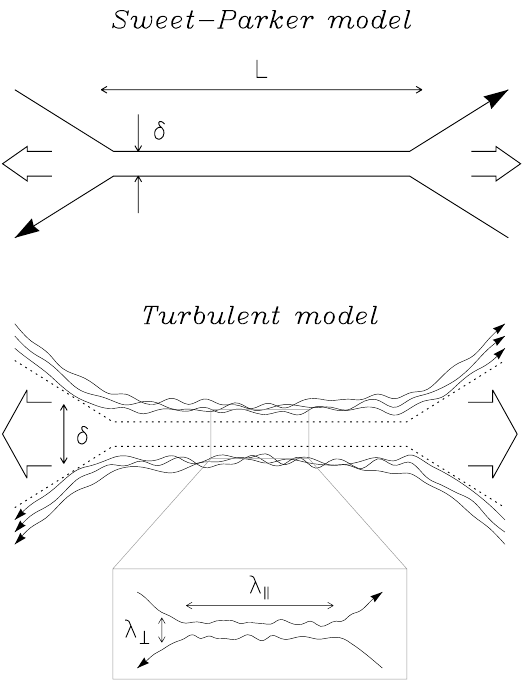
Fig. 1. Upper plot : The Sweet-Parker reconnection model. The outflow is confined to a thin layer of δ , which is set by Ohmic diffu- sivity. The length of the current sheet is a macroscopic scale L (cid:29) δ . Magnetic field lines are assumed to be laminar. Middle plot : Re- connection in the presence of stochastic magnetic field lines. The stochasticity introduced by turbulence is weak and the mean field is clear direction. The outflow width is set by the diffusion of the magnetic field lines, which is a macroscopic process, independent of resistivity. Low plot : An individual small scale reconnection re- gion. The reconnection over small patches of magnetic field deter- mines the local reconnection rate. The global reconnection rate is substantially larger as many independent patches reconnect simul- taneously. Conservatively, the LV99 model assumes that the small scale events happen at a slow Sweet-Parker rate. Following Lazar- ian et al. (2004) and Kowal et al.